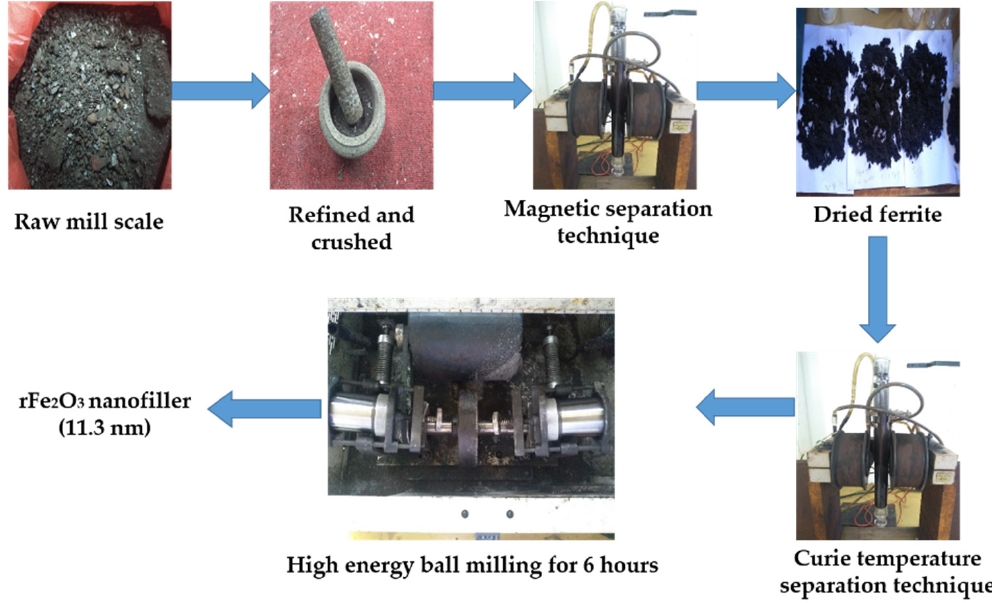
Figure 1. Preparation process of rFe 2 O 3 nanoparticles.